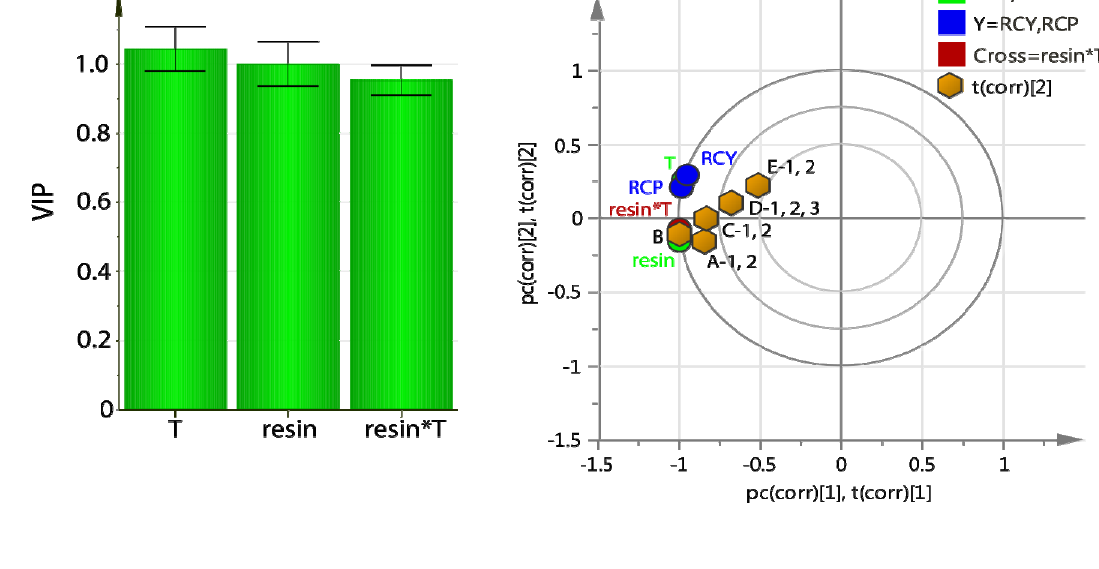
Figure 4. On-column radiofluorination of Np(CH important for the projection (VIP) plot ( left ) and bi-plot of loadings and scores (t), ( right